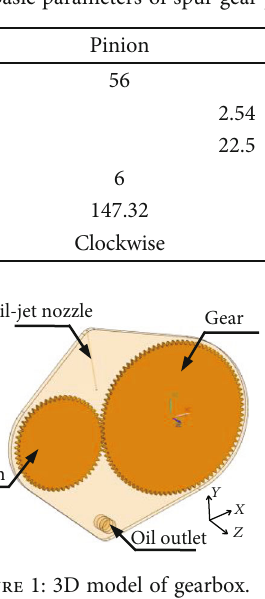
Table 1: Basic parameters of spur gear pair.